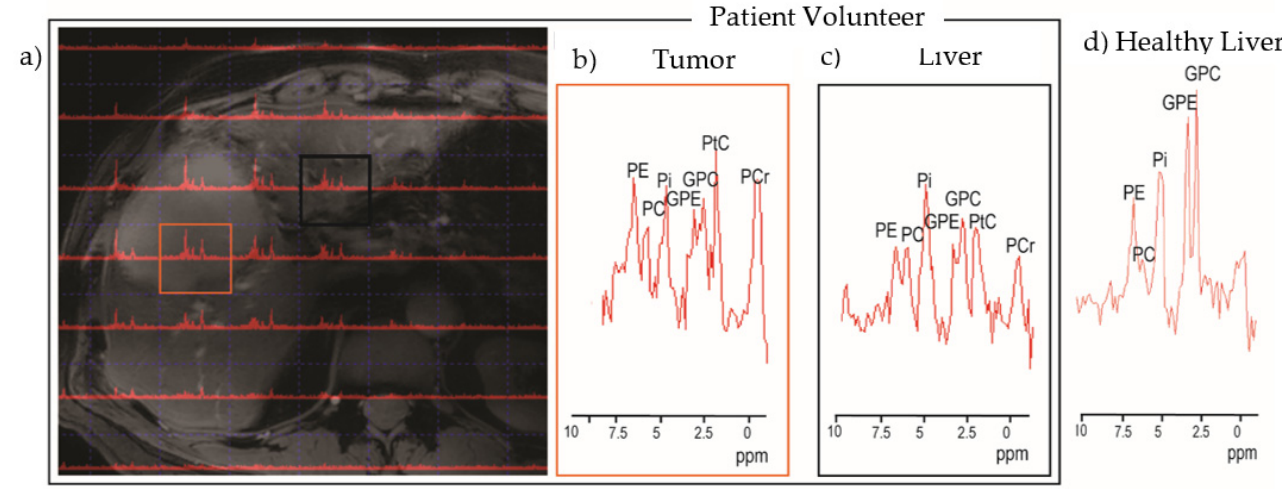
Figure 4. Non-overlapping measures for patients versus healthy tissue in vivo. ( a ) Data from pri- mary liver tumors demonstrates that the phosphomonoester (e.g., phosphocholine (PC) and phos- phoethanolamine (PE)) to phosphodiester ratio of the primary tumor spectra did not overlap with the ratios from any of the volunteers ( n = 28; mean +/ − 2 standard deviations); from Cox et al. [33]. Open circles represent hepatocellular carcinomas, while open squares indicate other primary liver tumors. Black circle indicates spectra from a healthy volunteer. ( b ) Similarly, the phosphomonoester (PE and PC) concentrations were non-overlapping with those of the healthy volunteers (7T, breast cancer; from Wijnen et al. [43]). Green shading delineates data points from tumors, and asterisks indicate datapoints collected using 1D chemical shift imaging instead of 2D.